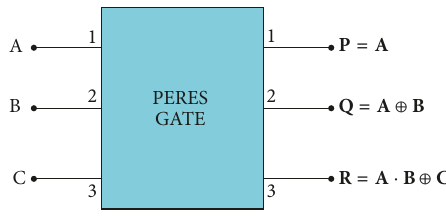
Figure 1: Block diagram of Peres